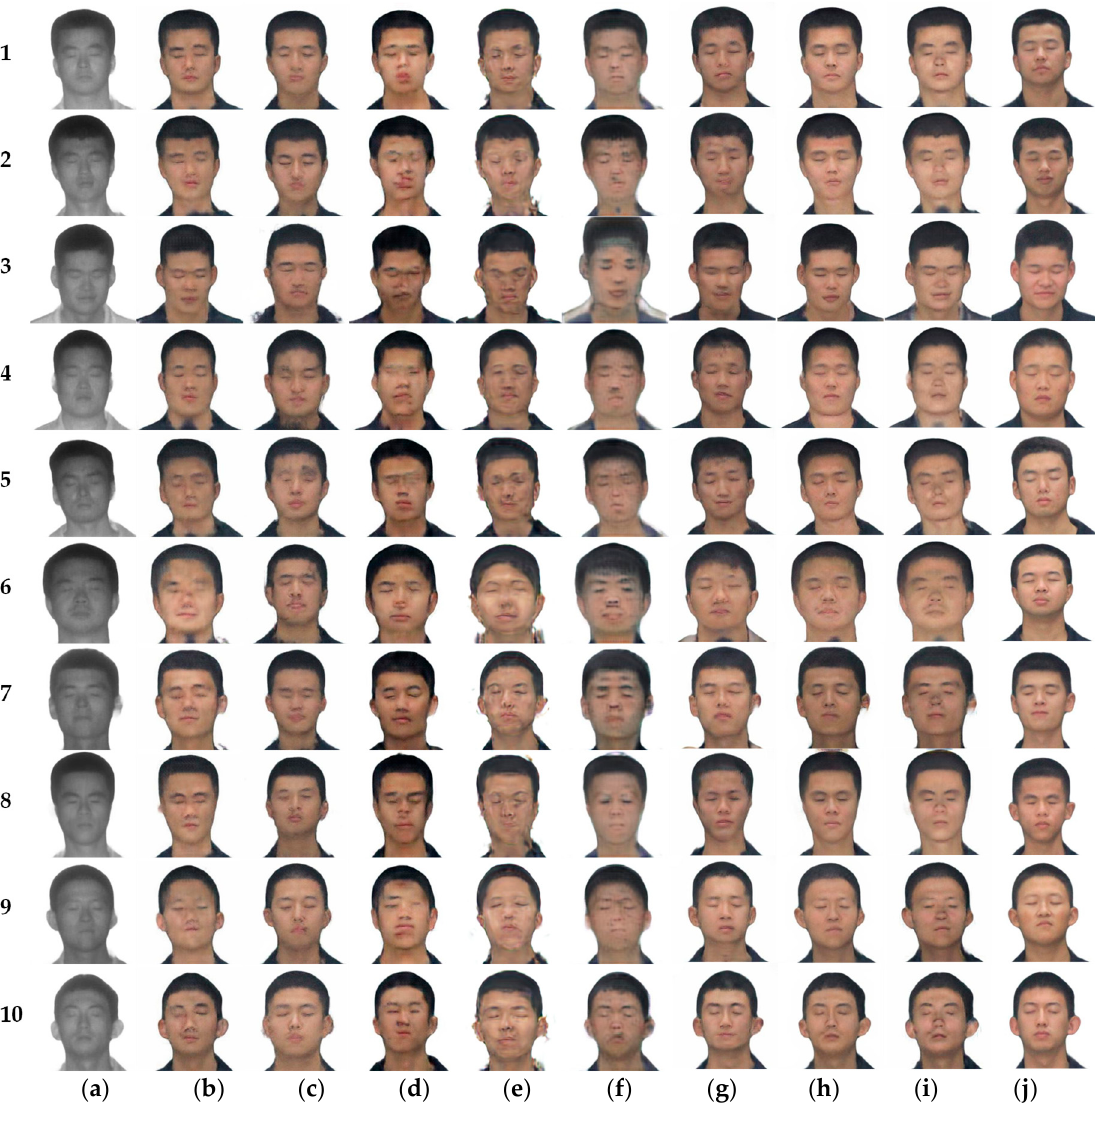
Figure 15. Different methods for Laser-visible facial image translation. ( a ) Laser image. ( b ) Cycle- GAN. ( c ) Pix2Pix. ( d ) UNIT. ( e ) UGATIT. ( f ) StarGAN. ( g ) DCLGAN. ( h ) SN-CycleGAN. ( i ) Ours. ( j ) Ground